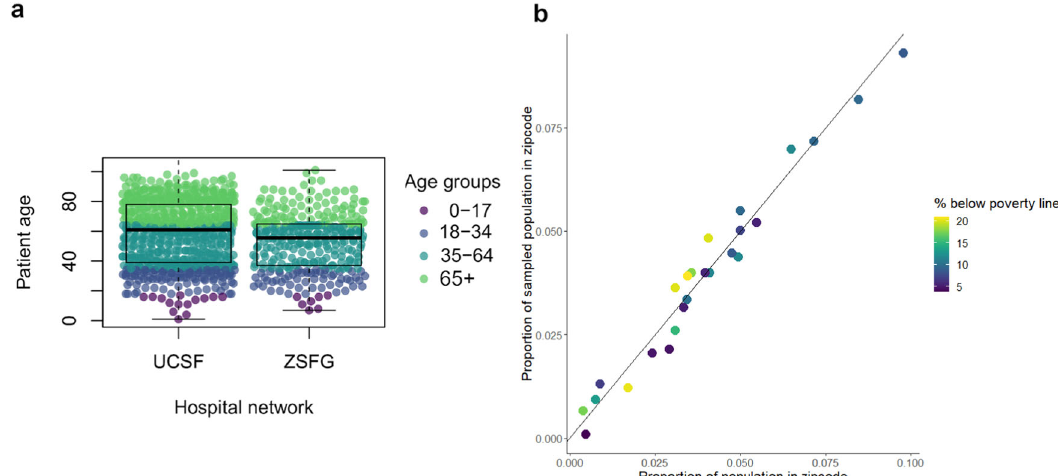
Fig. 1 Sample characteristics. a Age distribution by health network of sample collection within the University of California, San Francisco (UCSF) ( N = 698 biologically independent samples) and San Francisco Department of Public Health (ZSFG) hospital networks ( N = 316 biologically independent samples). Each point represents a sample and colors correspond to age bins used for analysis. The box plot whiskers show the maximum and minimum ages, the box shows the 25-75 th percentile values for age, and the central line within the boxplot represents the median age within each health network. b Proportion of samples from a given San Francisco zipcode plotted against the proportion of the San Francisco population within that zipcode. Colors show the percentage of residents below the poverty line within that zipcode, as determined by the American Community Survey 2019 15 , using census bureau de fi nitions of poverty thresholds 35